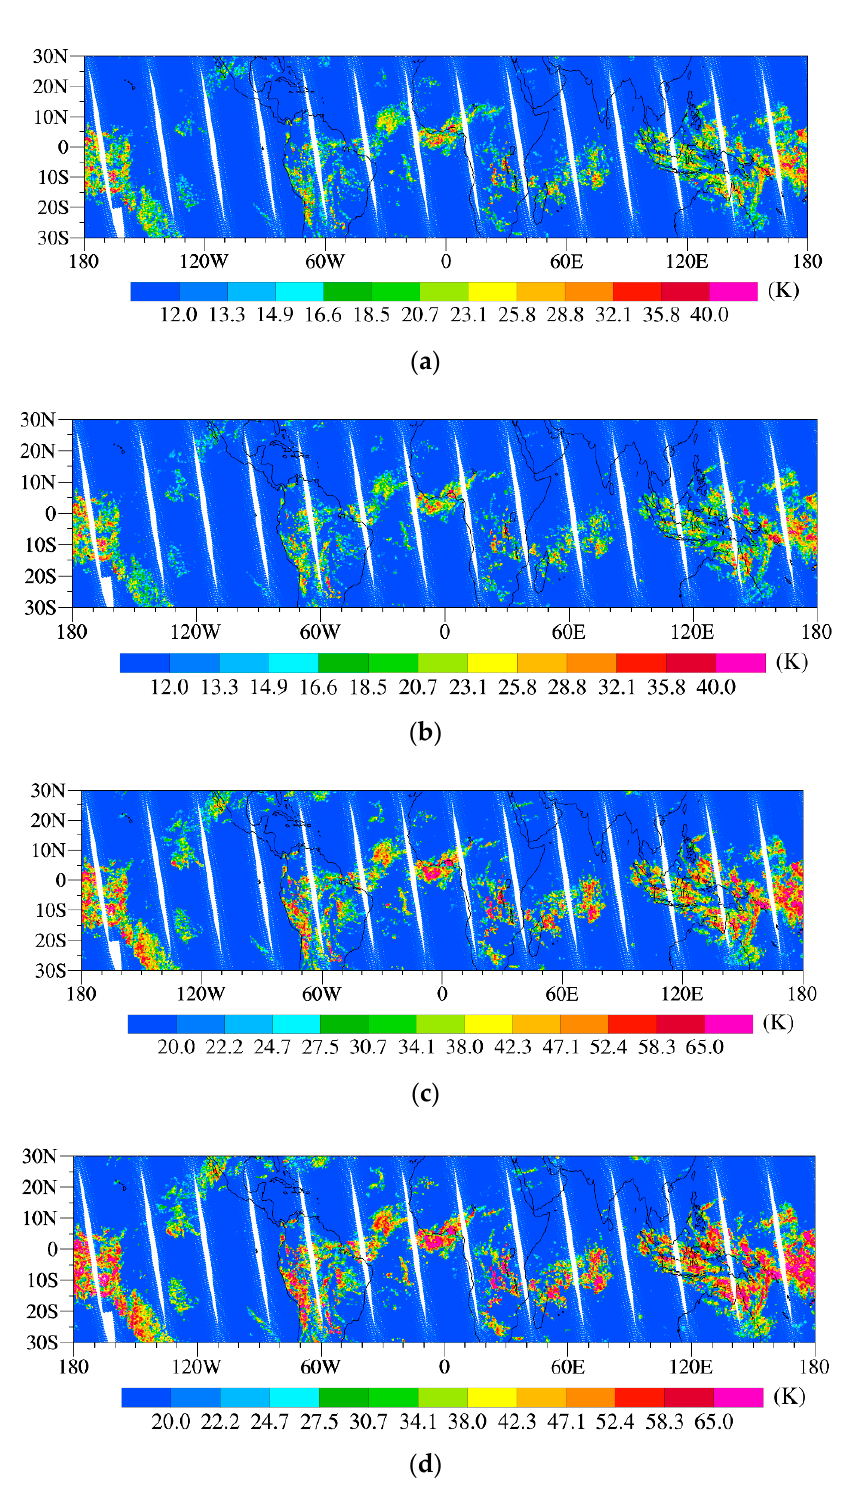
Figure 13. Spatial distributions of ( a ) CESI OM 19 (~628 hPa), ( b ) CESI OM 22 (~718 hPa), ( c ) CESI MM 21 (~628 hPa) and ( d ) CESI MM 24 (~718 hPa) at ascending nodes on 2 February 2019. Color interval for ln(CESI) is 0.126.